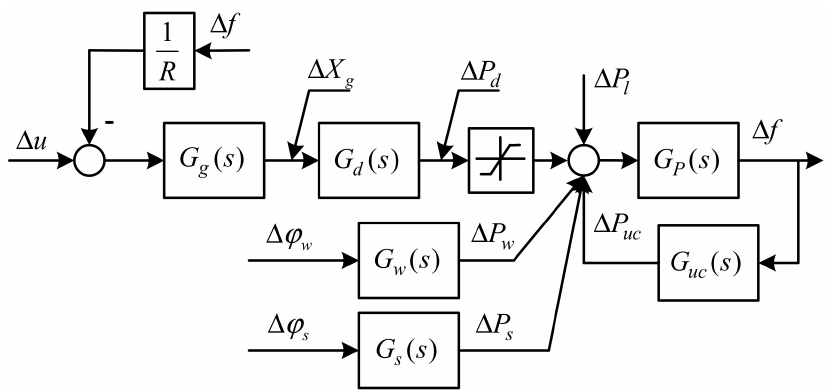
Figure 2. Load frequency